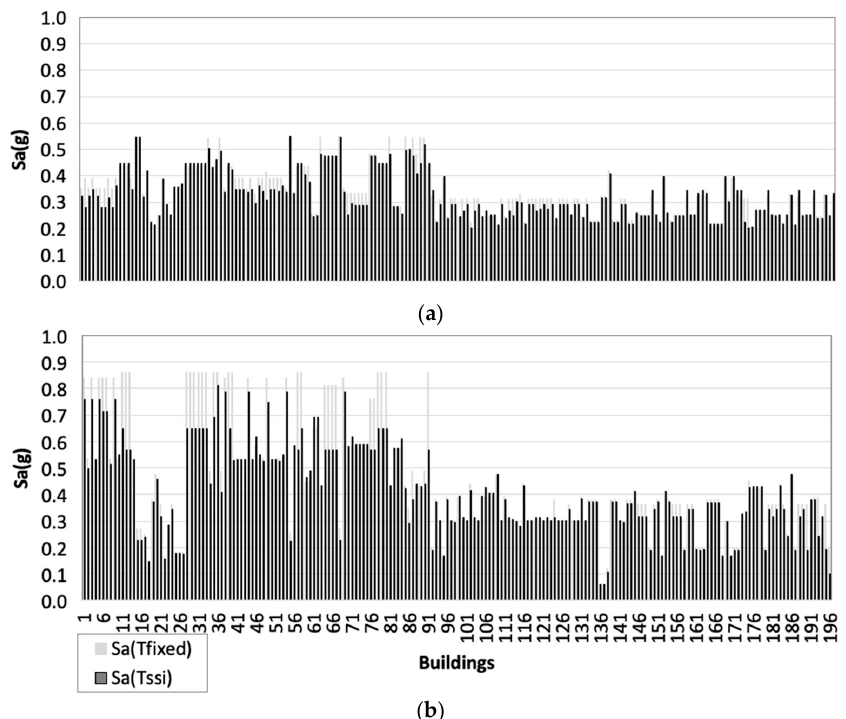
Figure 15. Spectral accelerations S a ( T SSI ) and S a ( T fixed ) evaluated for each building of the west area (shown in Figure 19a) for ( a ) 1818 input; ( b ) 2018 input.